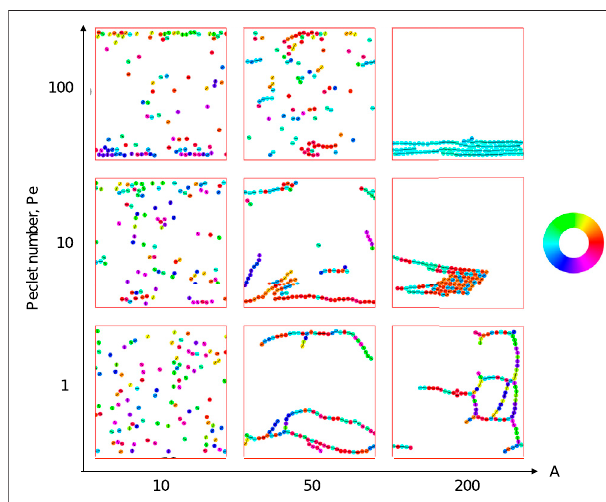
FIGURE 4 | Simulation snapshots of active particles at low packing fraction. The interaction parameter A ≡ P 2 / E σ 3 k B T eff and Péclet number Pe ≡ σ v fi ne the collective behavior of the particles. Particles are con fi ned in 0 / D T de the y -direction, while they experience periodic boundary conditions in the x -direction. They are colored based on the direction of ^ n , as indicated by the color wheel. At low interaction parameter A = 10, the particles remain isolated and diffuse ( Supplementary Movie S6 ). At high Pe , more particles get collected at the con fi ning boundary. At higher values of the interaction parameter, A , particles form chains. The typical length of the chains is seen to decrease with increasing Pe . At very high interaction parameter, A = 200, networks with multiple branches form at low Pe , while chains aggregate into polar clusters at Pe = 10 ( Supplementary Movie S7 ). Although the particles in the cluster are oriented in opposite directions, the cluster is stable and movesinthedirectiongivenbyitsoverallpolarity.AgainatveryhighPéclet, Pe = 100, the particles in the chains are oriented in the same